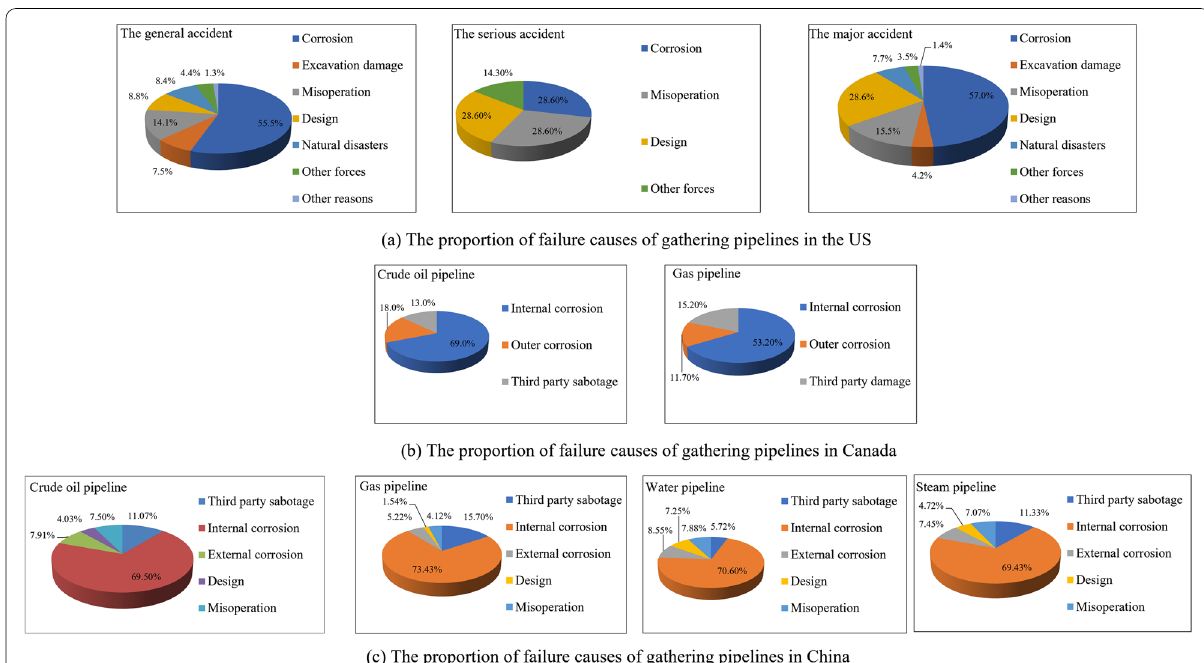
Fig. 1 Gathering pipeline accident